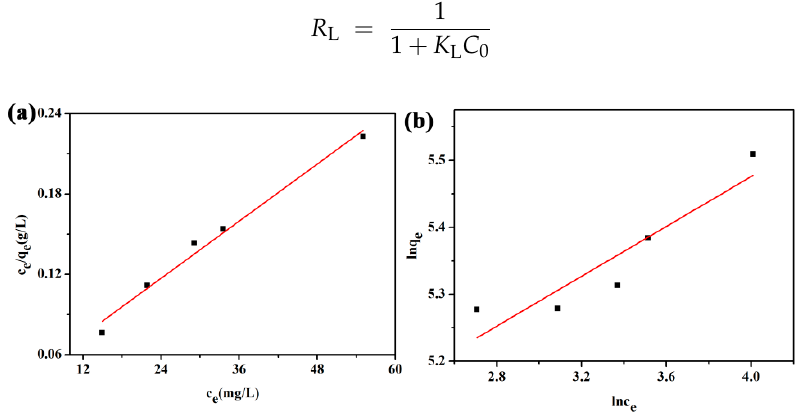
Figure 7. ( a ) Langmuir isotherm and ( b ) and Freundlich isotherm for adsorption of Pb(II) onto SPEN-CTAB-0%. Table 5. Langmuir and Freundlich isotherm constants for adsorption of Pb(II) onto SPEN-CTAB-0%.